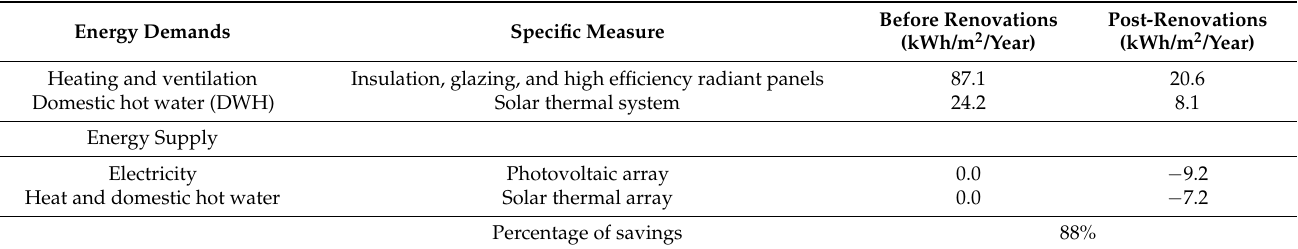
Table 1. Summary of the objective of improving energy performance in the United Kingdom.